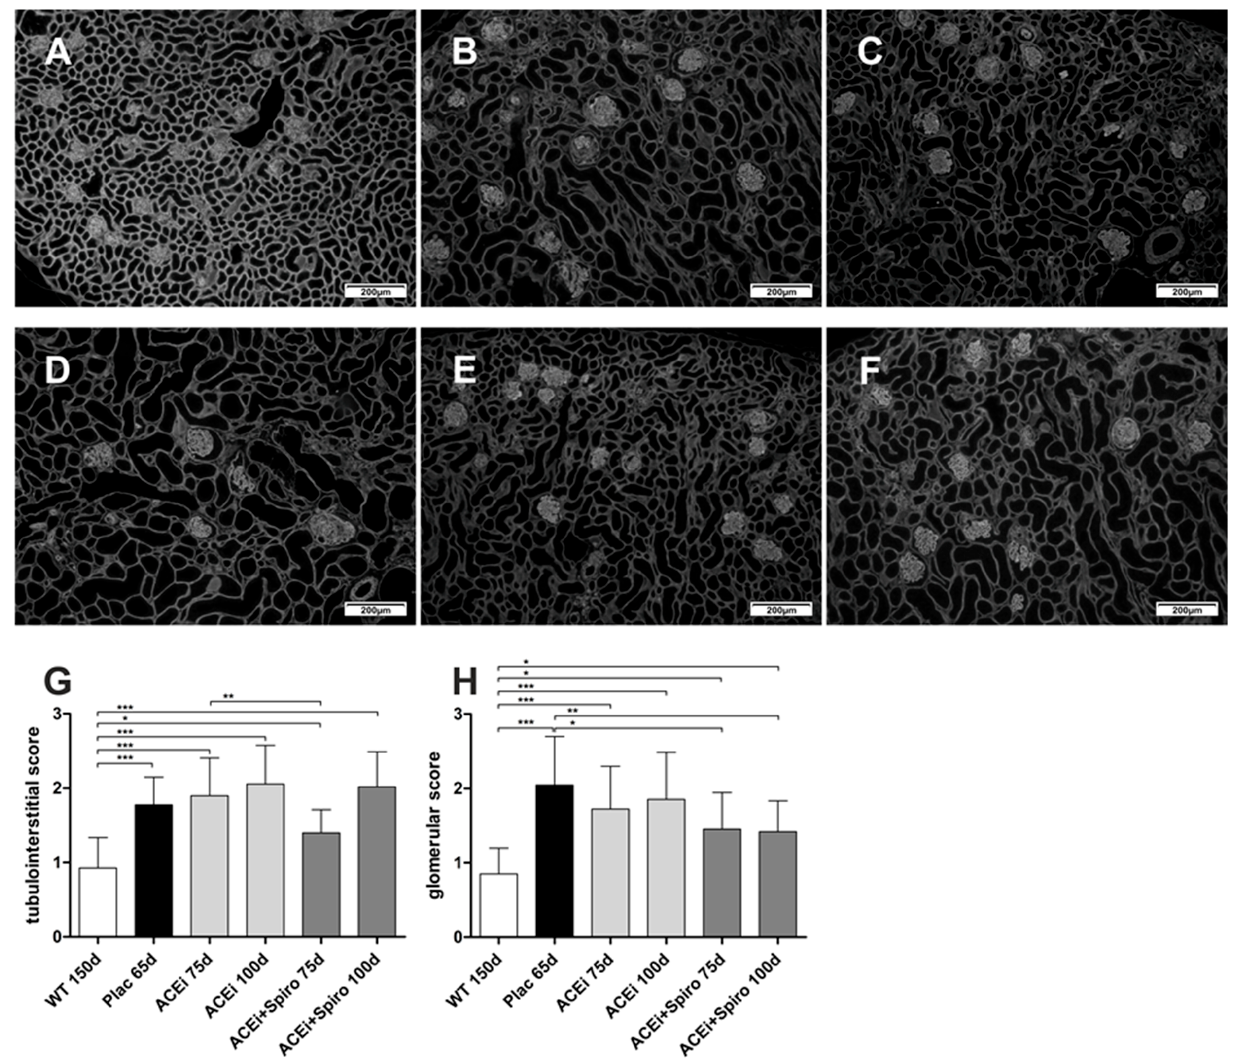
Figure 3. Therapeutic effect on matrix accumulation during pathogenesis of Alport Syndrome (AS). Immune-fluorescence staining of laminin 111, magnification 100-fold. ( A ) wildtype control; ( B ) Alport mice, ACEi 75 days; ( C ) Alport mice, ACEi 100 days; ( D ) Alport mice, Plac (untreated); ( E ) Alport mice, ACEi+Spiro 75 days; ( F ) Alport mice, ACEi-Spiro 100 days; ( G ) score for tubulointerstitial matrix accumulation ( n = 3 for each group); ( H ) score for glomerular matrix accumulation ( n = 3 for each group); *** p < 0.001; ** p < 0.01; * p < 0.05.